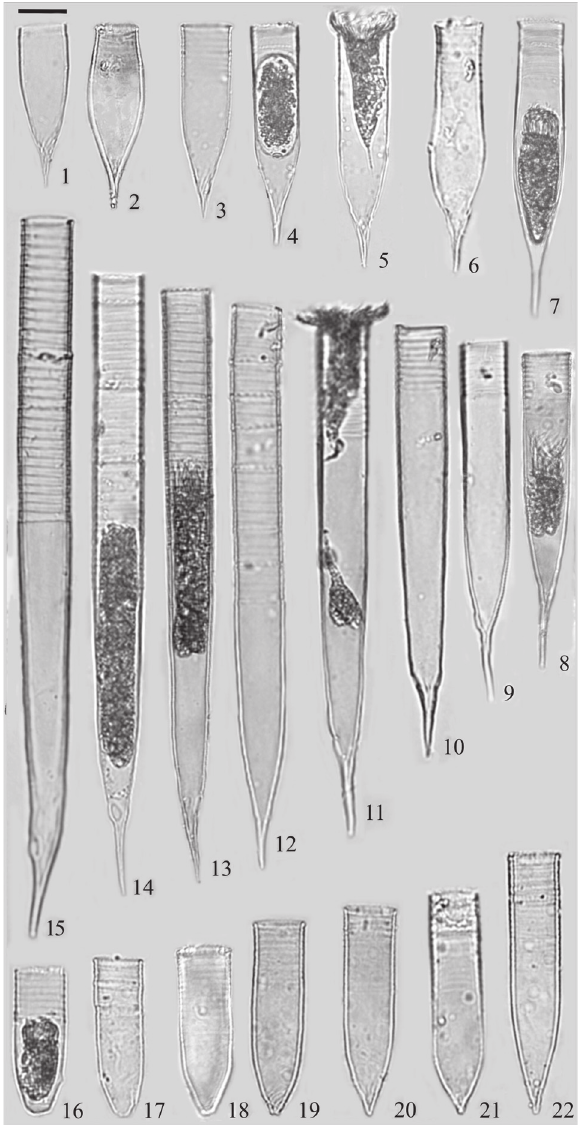
Fig . 3. – Variability of the loricae of Helicostomella in argentine shelf. Bar = 20